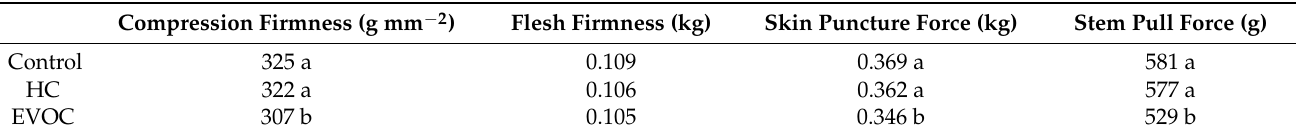
Table 6. Effect of dormancy-breaking agents on the harvest fruit firmness and stem pull force of the sweet cherry cultivar ‘Lapins’. HC = hydrogen cyanamide; EVOC = emulsified vegetable oil